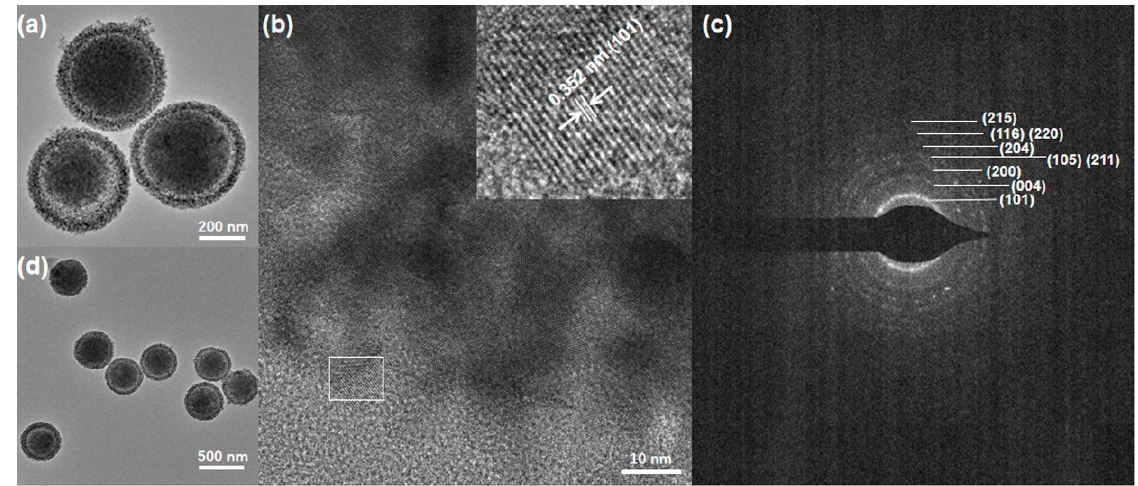
Figure 4. ( a) TEM image of SiO 2 @mTiO 2 , ( b ) HRTEM image of the anatase crystals of shell in SiO 2 @mTiO 2 , ( c ) the corresponding SAED pattern of SiO 2 @mTiO 2 and ( d ) TEM image of Eu(tta) 3 bpdc-SiO 2 @mTiO 2 .